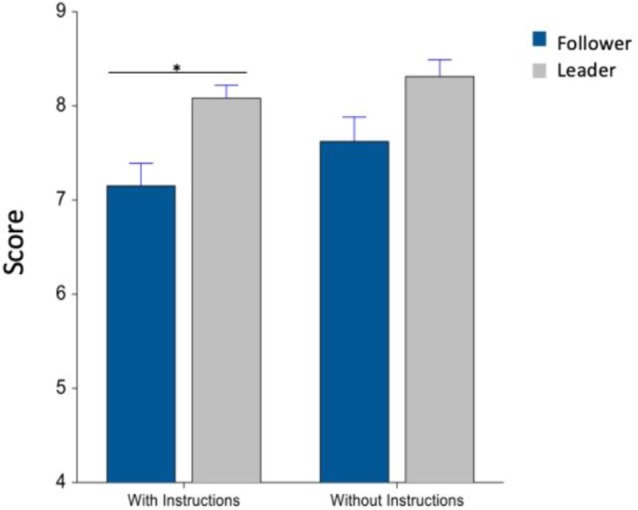
Ease of use of each machine, with and without instructions. Whiskers are standard error of the mean (SEM). *Means statistically significant difference.